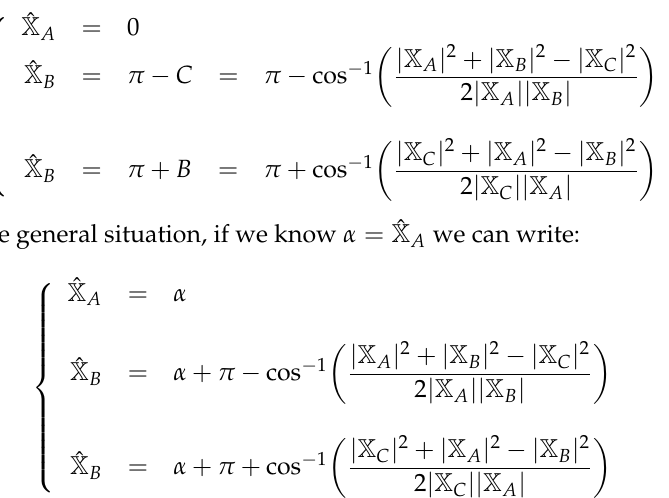
Figure A3. An unbalanced three-phase system